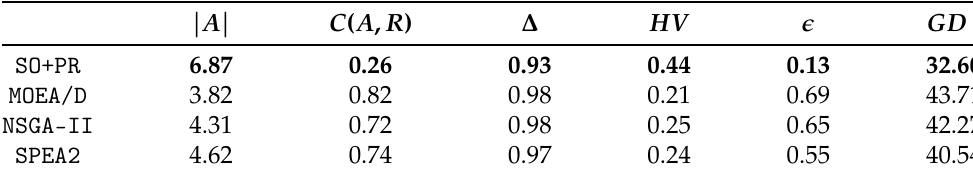
Table 5. Average results for k -BLC 123 on the pmed instances.